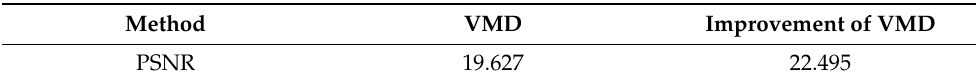
Table 1. Filtering effect comparison.